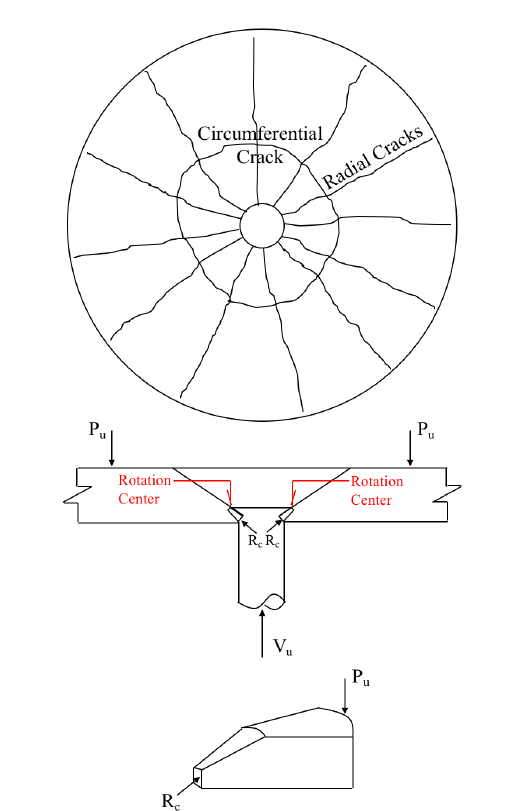
Figure 1. Mechanical model by Kinnunen & Nylander